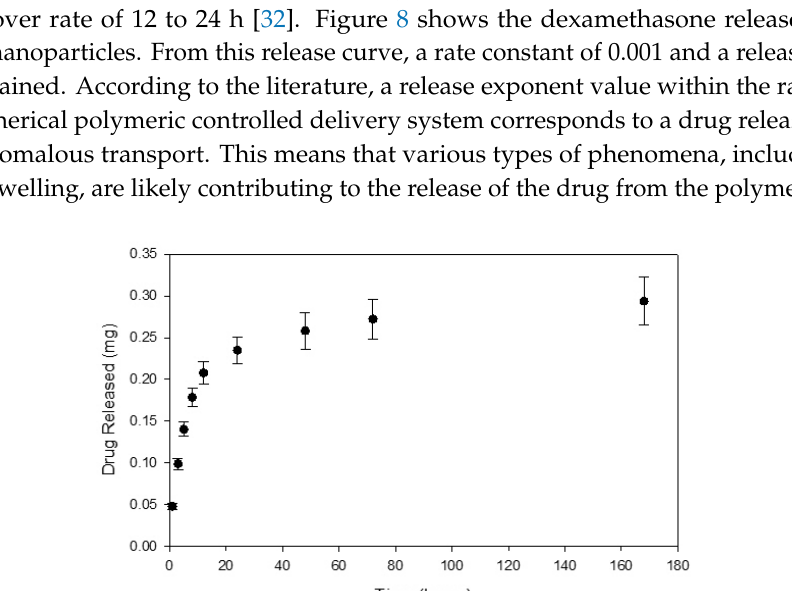
Figure 9. Dexamethasone release curve from loaded poly(HEMA, BAC, 3AAPBA) nanoparticles